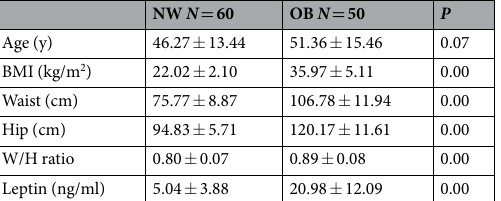
Table 1. Anthropometric parameters of participants with normal weight (NW) or with obesity (OB). Values (mean ± SD); P was assessed using an unpaired, two-tailed Student’s